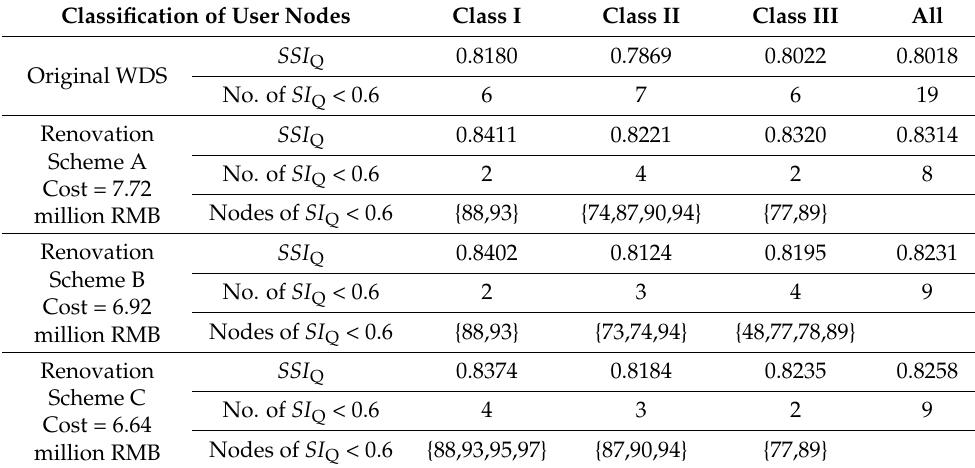
Table 8. Seismic performance of user